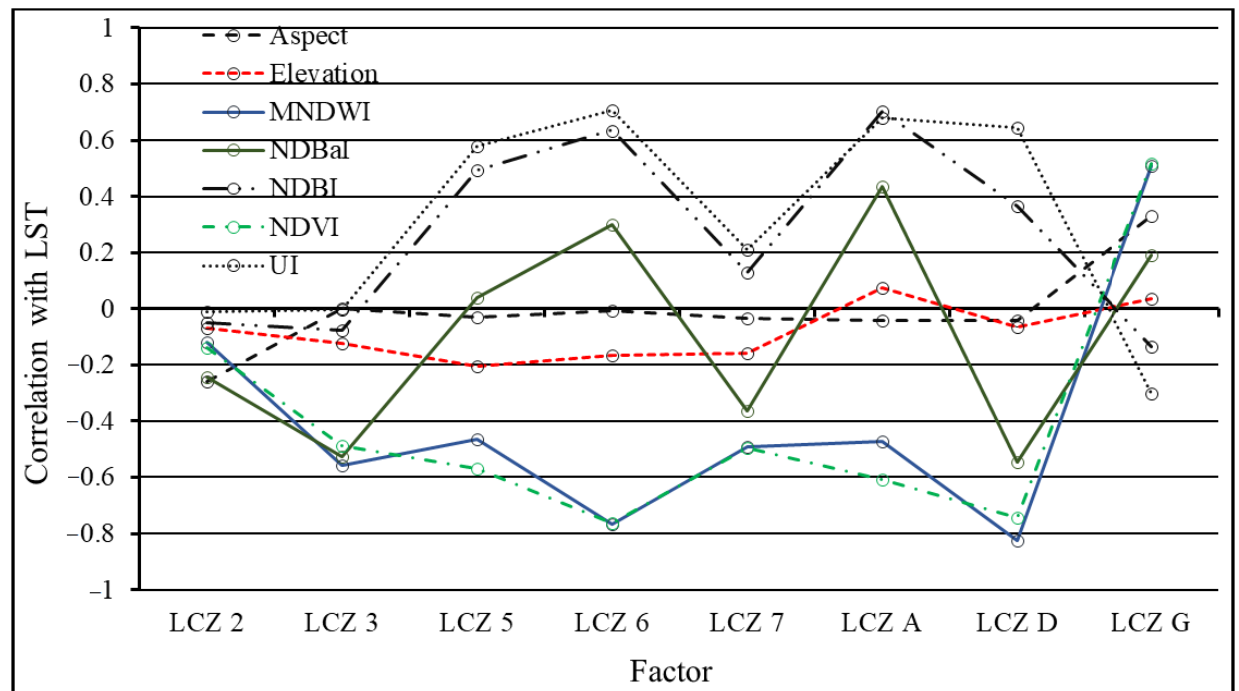
Figure 7. Intra-LCZ correlation of LST and land surface properties.